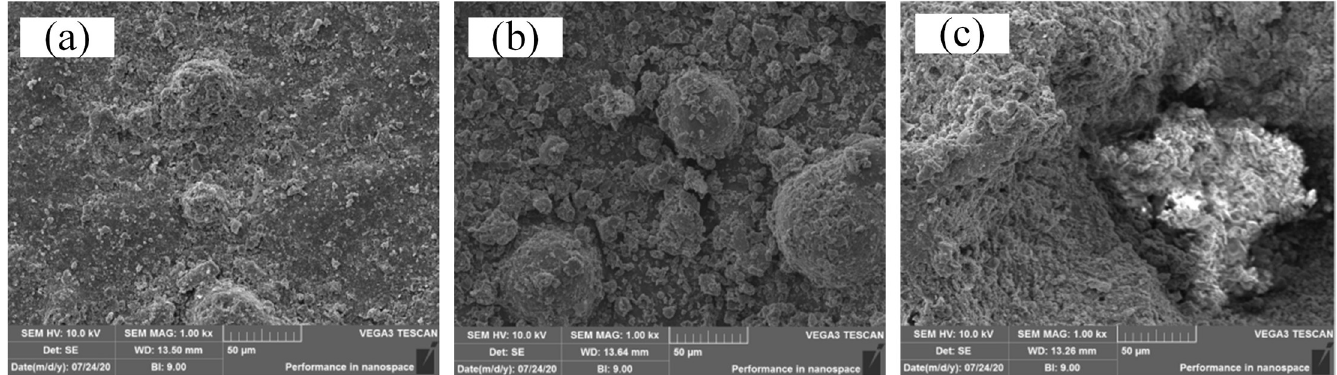
Fig 6. Three RTV samples with relatively different surface roughness. (a) RTV samples with surface roughness of 10–40 μ m; (b) RTV samples with surface roughness of 40–100 μ m; (c) RTV samples with surface roughness of more than 100 μ m.